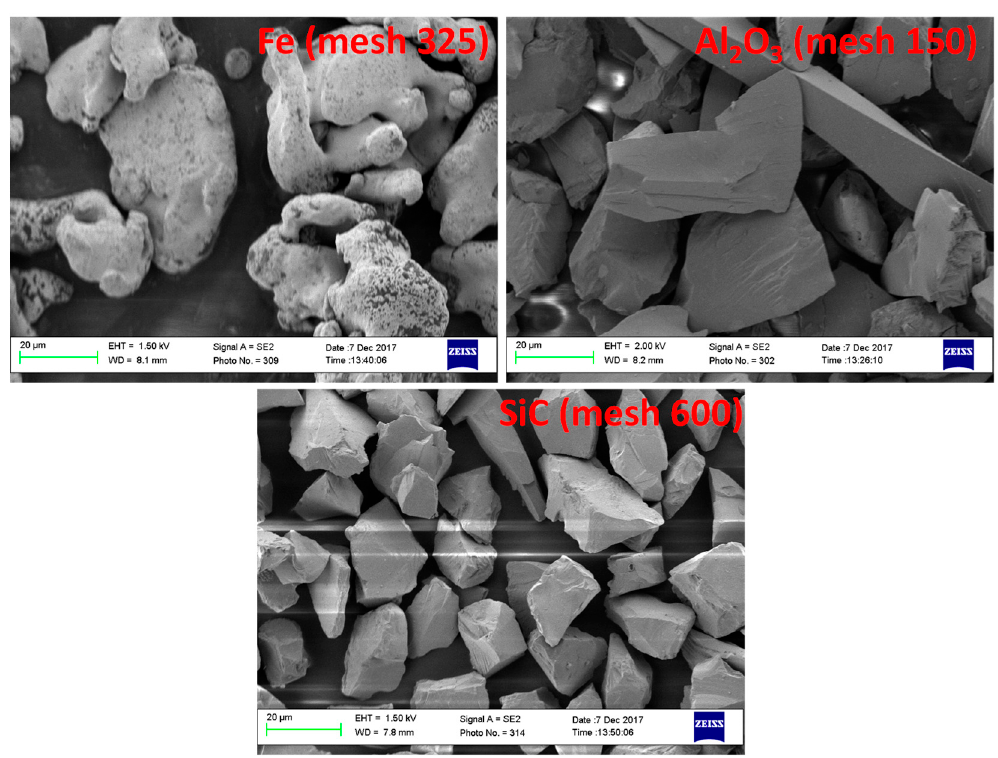
Figure 2. Representative SEM images of magnetic Fe, and abrasive Al 2 O 3 and SiC particles.